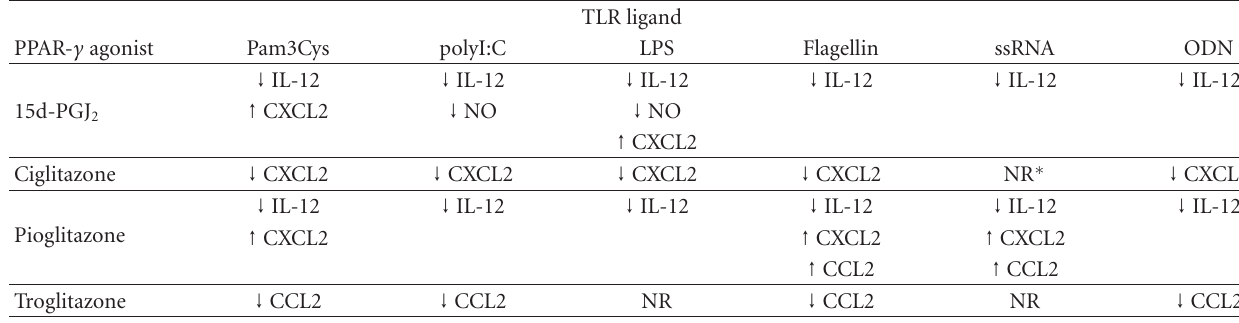
Table 2: Summary of PPAR- γ e ff ects on PAMP-activated astrocytes reported in this